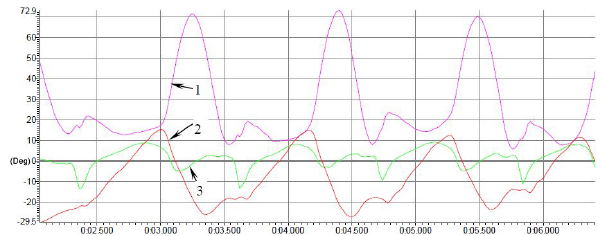
Figure 6. 1 – knee flexion/extension; 2 – hip flexion/extension; 3 – ankle flexion/extension; The experimental angles variations for dis- abled human, in sagittal plane, for left leg (disabled leg).